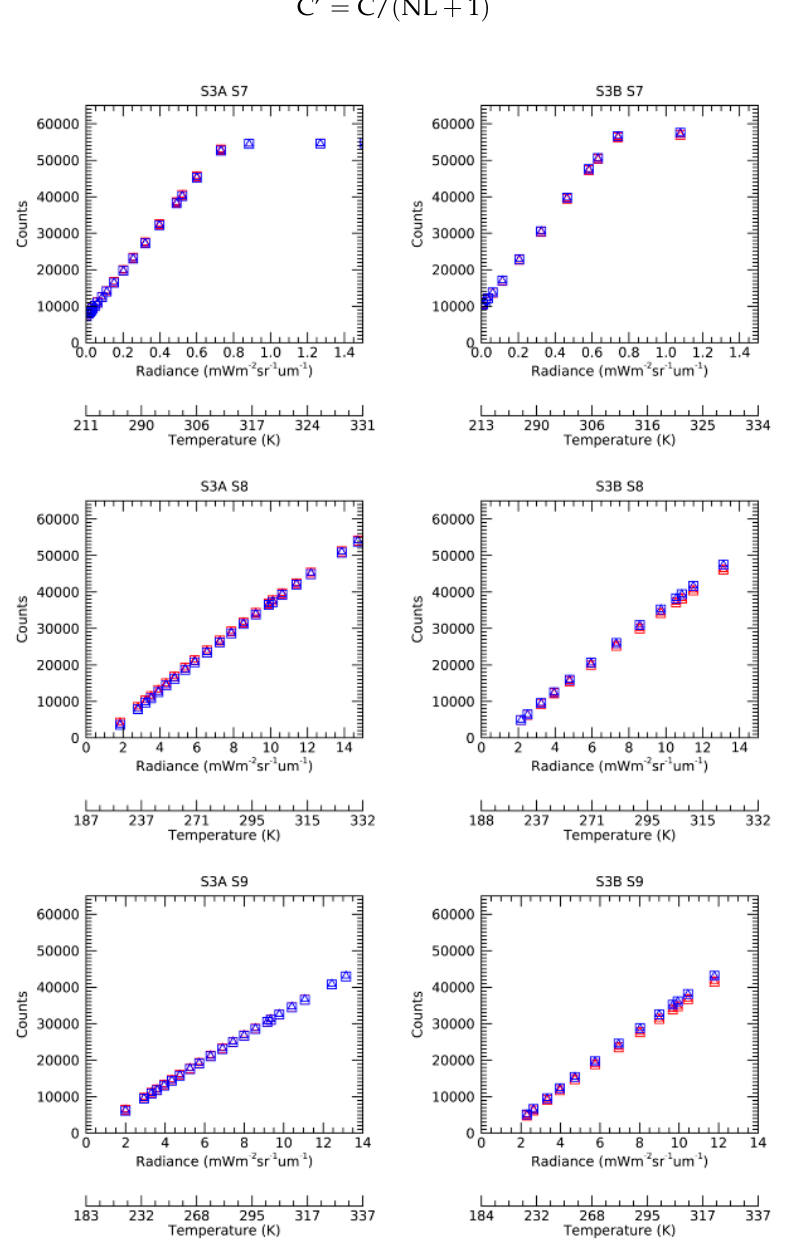
Figure 4. SLSTR-A (left) and SLSTR-B (right) nadir view measured detector counts vs. scene radiances and brightness temperatures for channels S7–S9. The oblique view shows a similar behavior and is not displayed for that reason. The corresponding scene temperature is shown in the lower axes. ☐ = Detector 1, Integrator 1; ☐ = Detector 1, Integrator 2; Δ = Detector 2, Integrator 1; Δ = Detector 2, Integrator 2. The SLSTR Thermal Infrared (TIR) channels have two detector elements in the along-track direction and are read out in alternate integration cycles, which are calibrated separately. Table 5. Minimum and maximum scene temperatures for SLSTR-A and B. SLSTR-A SLSTR-B Nadir Oblique Nadir Oblique